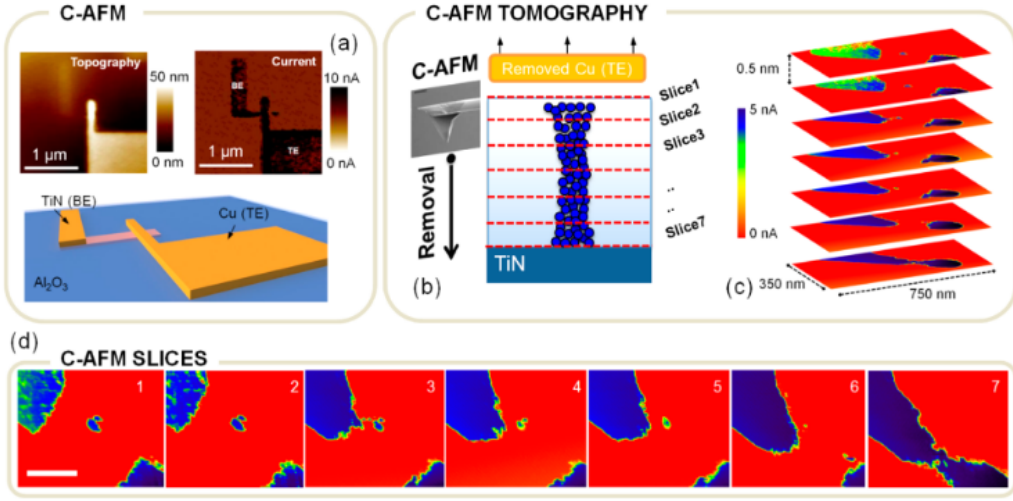
Figure 5: (a) Planar 2D C-AFM, performed on Cu/Al 2 0 3 /TiN ReRAM crosspoint while it is in LRS, due to the shielding effect of top Cu elec- trode Conducting filaments(CF) were not observed.(b) Elucidates the C-AFM tomography procedure, where in order to collect several slices at different heights of the CF, a diamond tip is employed. (c) Over imposition of the collected 2D C-AFM slices, prior to the 3D interpolation. Note, the average space between each slice is ~0.5 nm. (d) The data set for the 3D interpolation is constituted by collection of 2D slices, and the CF is observed near the center of the active electrode upon removal of top electrode. The top-left and bottom right region exhib- ited highly conductive features corresponding to exposed region of the TiN BE, which is gradually exposed during the process of Al 2 O 3 removal. (Reprinted with permission from U. Celano, L. Goux, A. Belmonte, K. Opsomer, A. Franquet, A. Schulze, C. Detavernier, O. Richard,